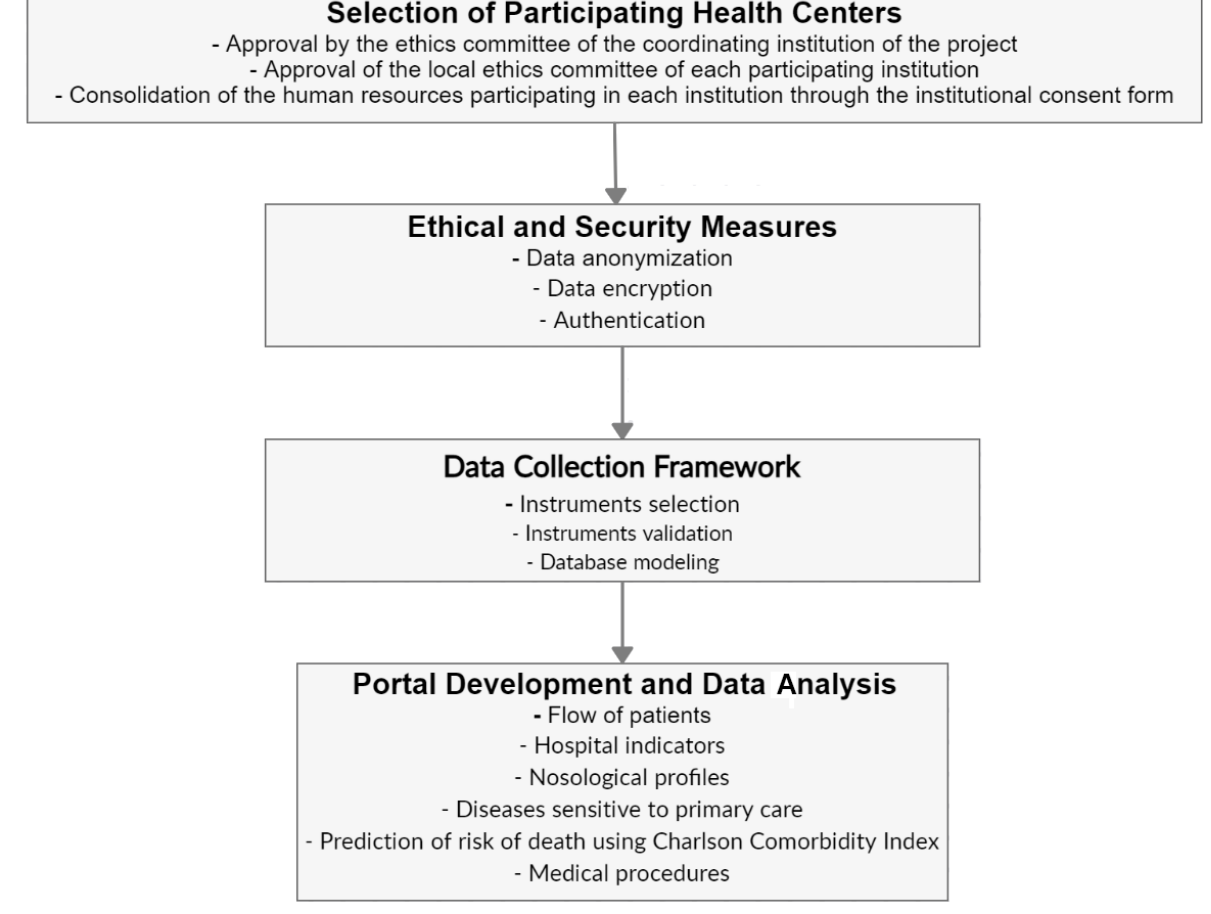
Figure 2. Main activities of